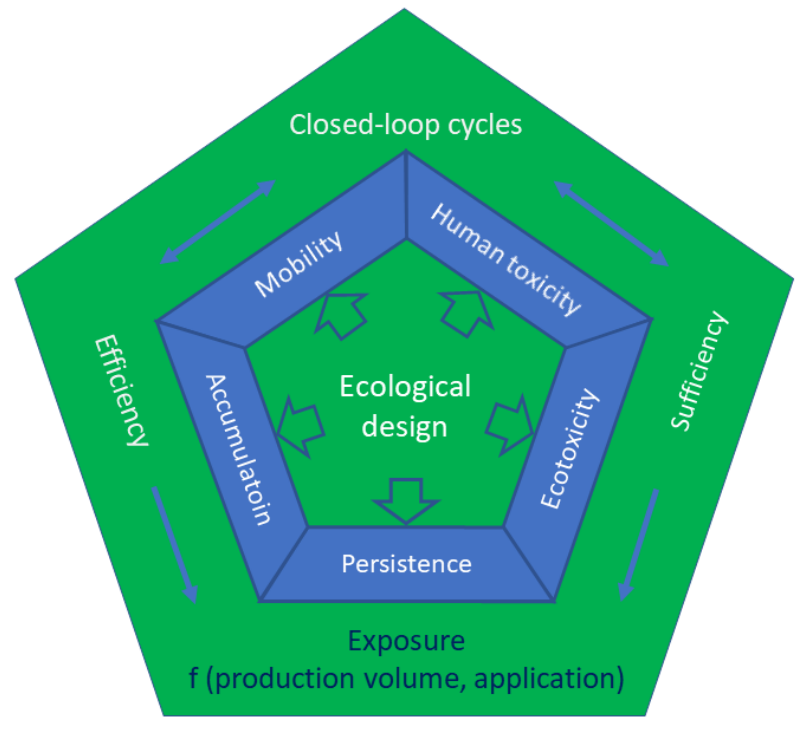
Figure 7. Minimizing the risks of chemicals by reducing exposure and effects (according to Friege [175]).